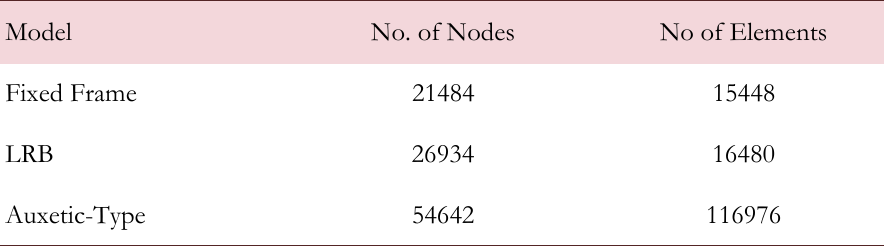
Table 2: Number of nodes and elements per model.